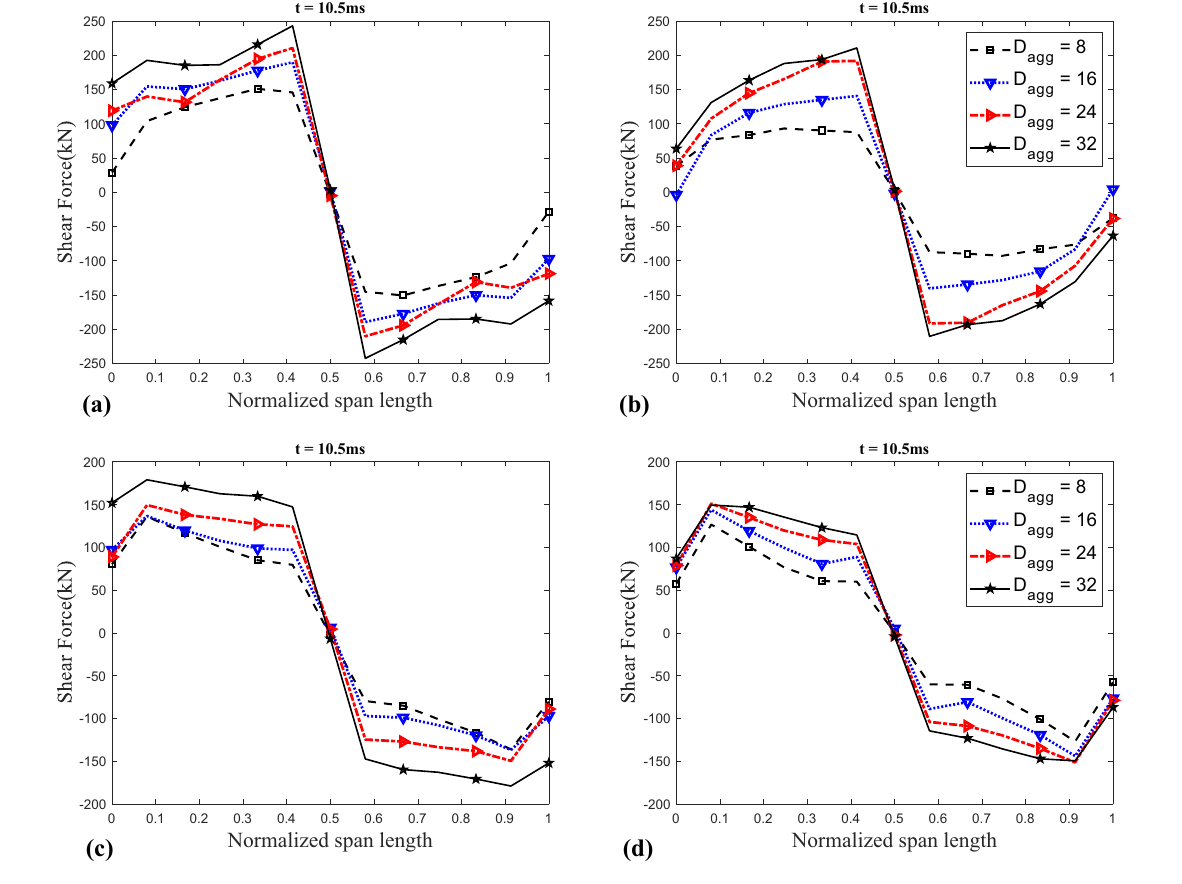
Fig. 16 Shear force diagrams at t = 10.5 ms for a CV1, b CV2, c CV3, and d CV4